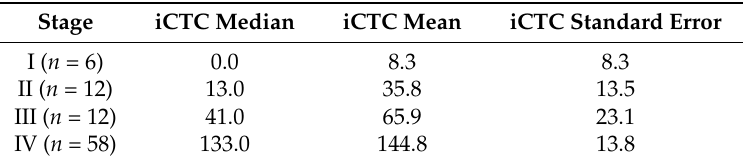
Table 3. iCTC median, mean and SD.